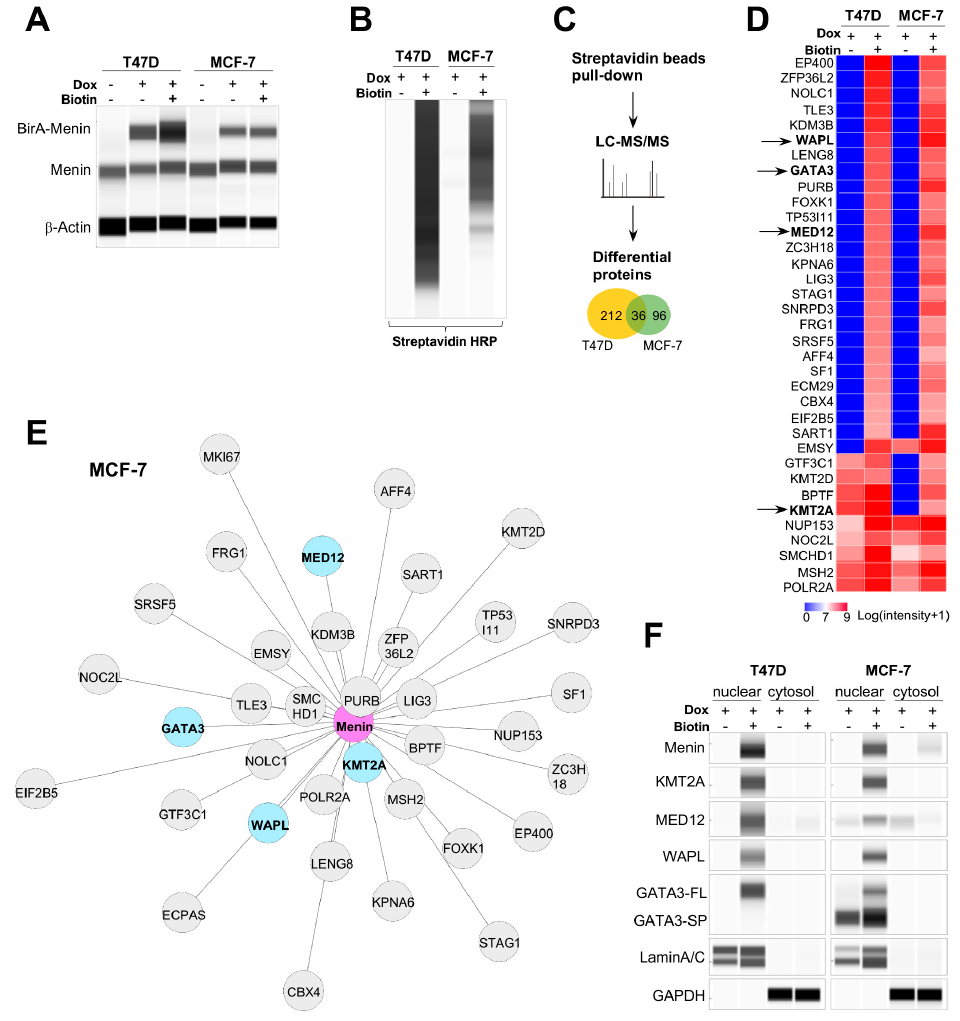
Figure 2. Identification of menin-associated proteins (MAPs) in breast cancer cells. ( A ) and ( B ) WES of BirA-Menin fusion proteins ( A ) and biotin-labeled proteins ( B ) in total lysates of BirA-MEN1 BioID engineered T47D or MCF-7 cells after incubating with or without doxycycline and biotin. ( C ) Schematic purification and proteomic identification of MAPs using LC–MS / MS. ( D ) Heatmap of the quantification of 35 MAPs commonly shared in T47D and MCF-7 cells. MAPs further verified by WES immunoassays were indicated by arrows. ( E ) Network analysis of 35 MAPs in MCF-7 cells. The distance between menin and MAPs represented the quantitative ratio of each MAP and menin. MAPs marked in blue were further assayed by WES. ( F ) Nuclear or cytoplasmic lysates of BirA-MEN1 BioID engineered T47D or MCF-7 cells after streptavidin beads pull-down were detected by WES with antibodies against menin, KMT2A, MED12, WAPL, GATA3, LaminA / C, or GAPDH. FL, full length; SP, spliced form.